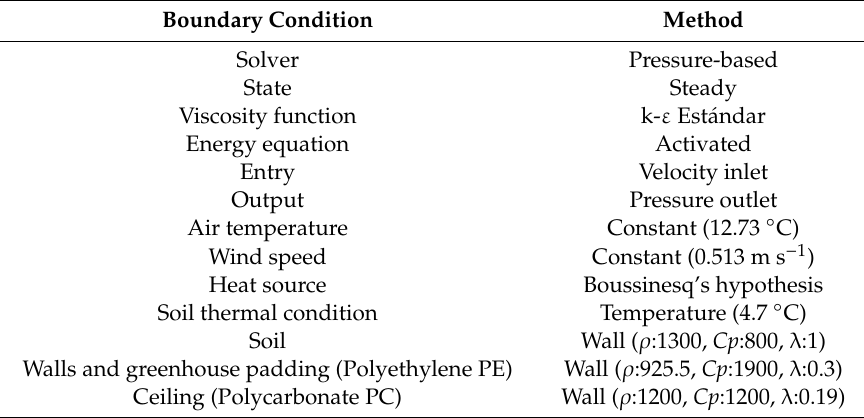
Table 3. Boundary conditions of the computational